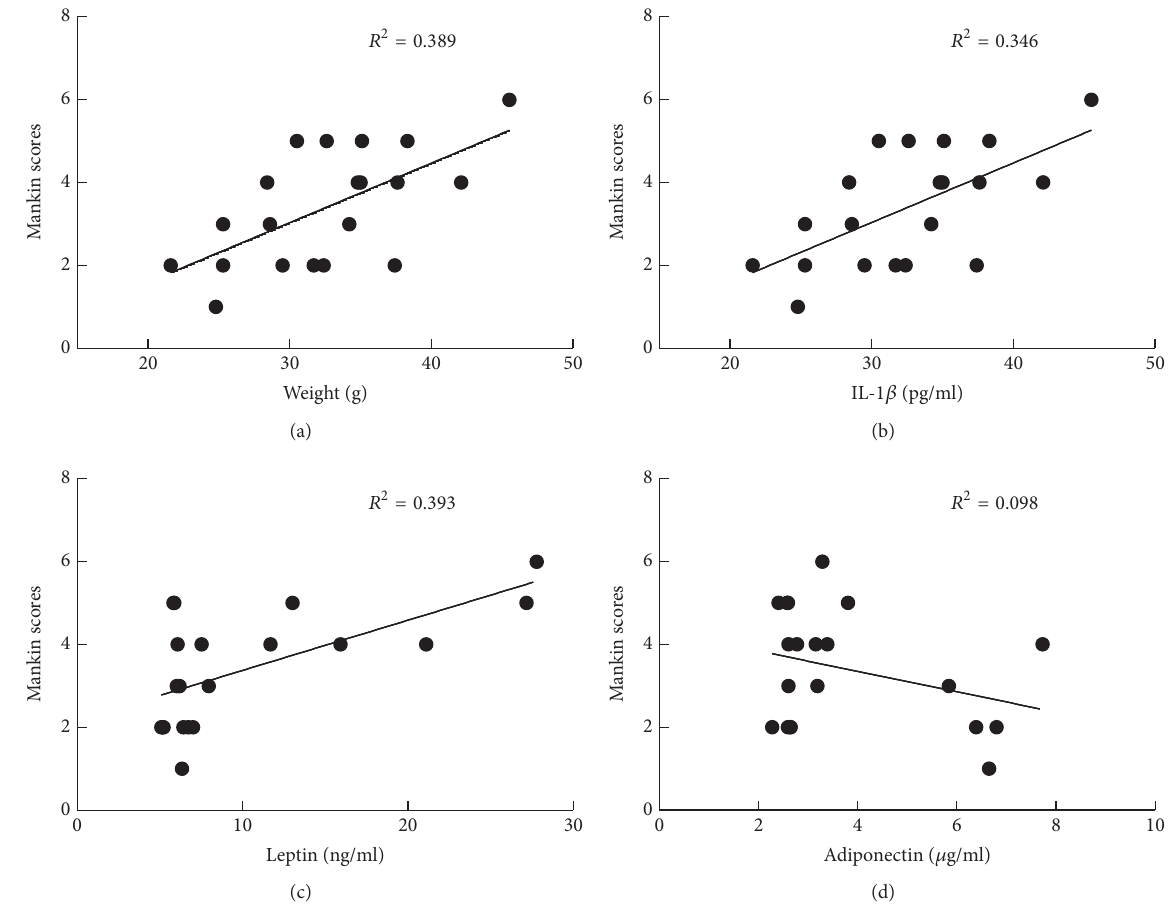
Figure 4: Correlation analysis between body weight, IL-1 𝛽 , leptin, adiponectin levels, and Mankin scores. Pearson’s correlation coefficient was calculated for each pair of parameters: (a) body weight and Mankin scores, 𝑅 2 = 0.389 , 𝑃 = 0.003 ; (b) serum IL-1 𝛽 levels and Mankin scores, 𝑅 2 = 0.346 , 𝑃 = 0.006 ; (c) serum leptin levels and Mankin scores, 𝑅 2 = 0.393 , 𝑃 = 0.003 ; (d) serum adiponectin levels and Mankin scores, 𝑅 2 = 0.098 , 𝑃 = 0.179 . Each point on the graph represented a single mouse. 𝑛 = 5 mice per